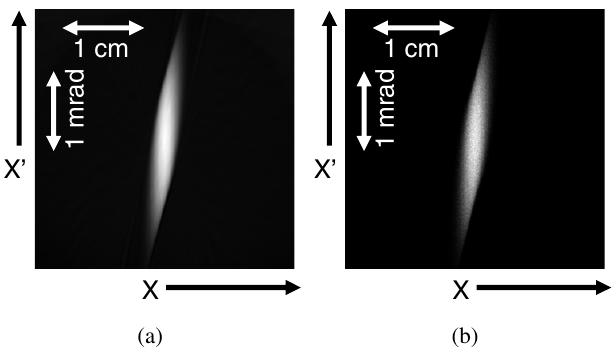
FIG. 6. X 0 X phase space distribution of the 7 mA electron beam: (a) by tomography; (b) by direct WARP simulation.